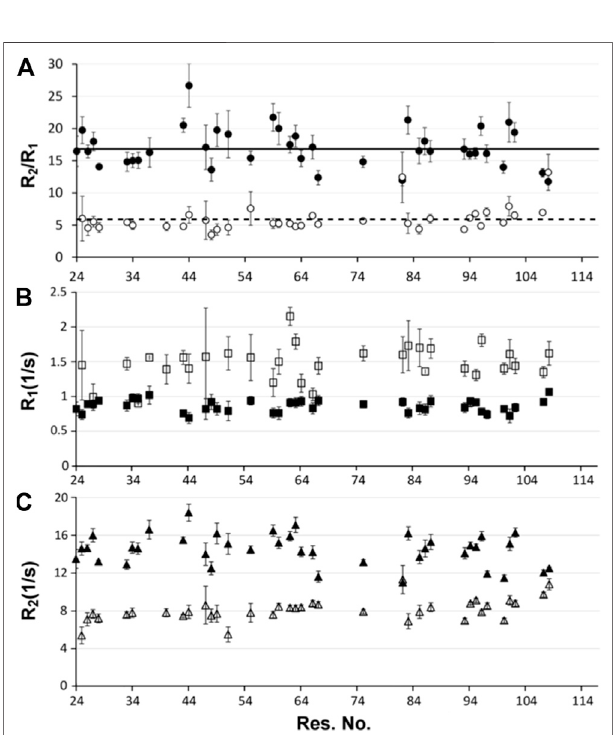
FIGURE 3 | NMR relaxation analysis (A) R 2 /R 1 ratios, (B) R 1 and (C) R 2 of distinct T. maritima RNase P protein conformers. The dominant P protein conformer at 466 μ M is shown in fi lled circles, rectangles, and triangles in the three plots, respectively; while the minor conformer is presented as the open/white fi lled symbols. The R 2 /R 1 ratio (A), as well as individual R 1 (B) and R 2 (C) relaxation experiments were performed on a 466 uM P protein sample at 318K. For each data set, errors represent multiple 15 N T 2 and T 1 relaxation experiments in addition to the uncertainty of the exponential fi t. The average R 1 , R 2 , and R 2 /R 1 ratios of the dominant and minor P protein conformations are indicated as solid and dashed lines,